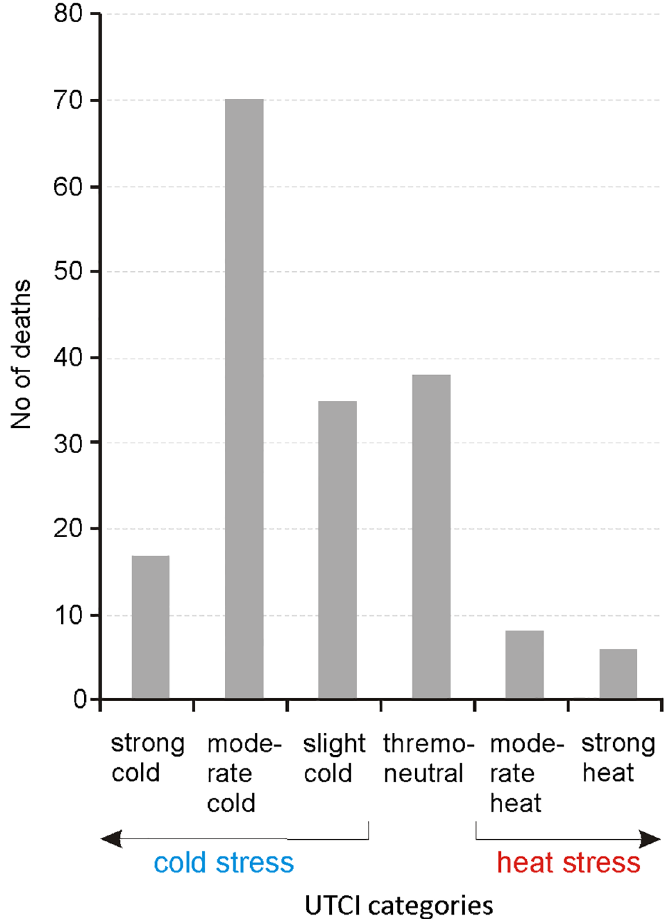
Fig 2. Number of deaths in categories of thermal stress according to UTCI (n = 174).